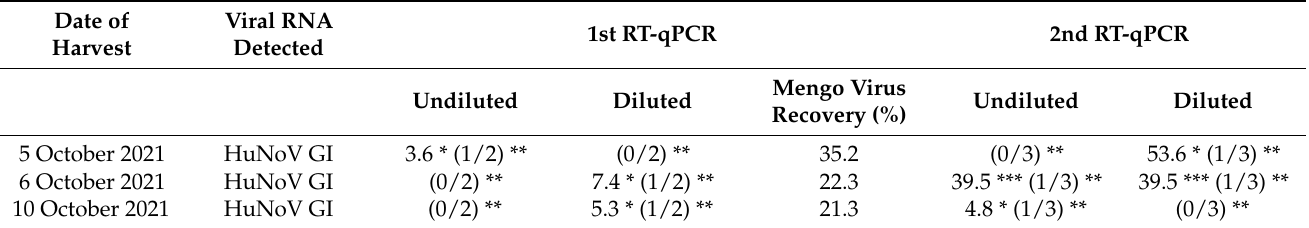
Table 4. Summary of HuNoV-positive cranberry sample results *.